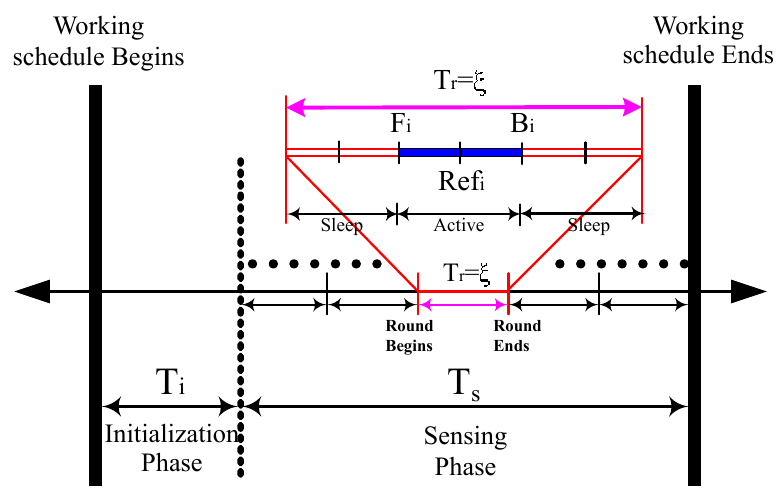
Figure 5. The working schedule of a sensor in